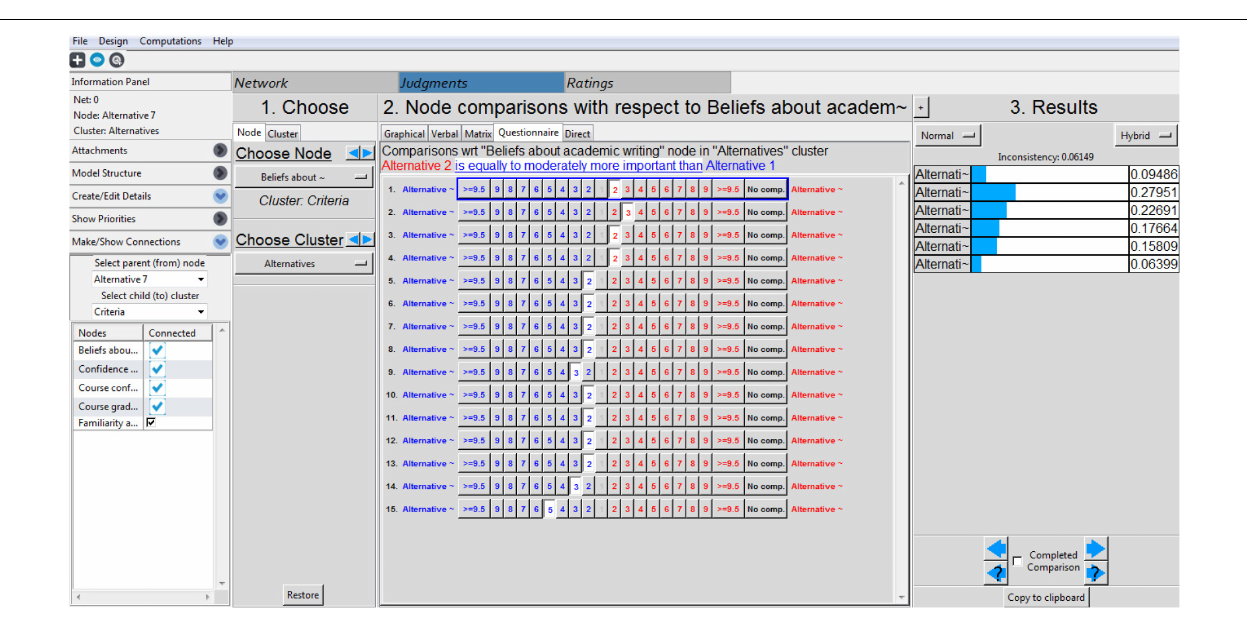
FIGURE 2 | Comparison process of alternative based on the defined criteria. Permission to reproduce images of Super Decisions has been given by Creative Decisions